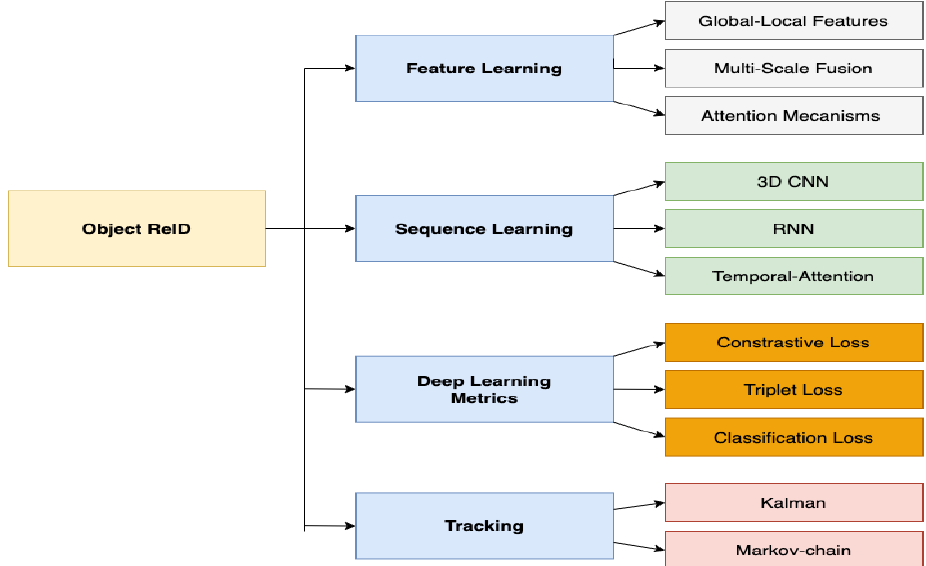
Figure 10. Deep learning-based vehicle re-identification